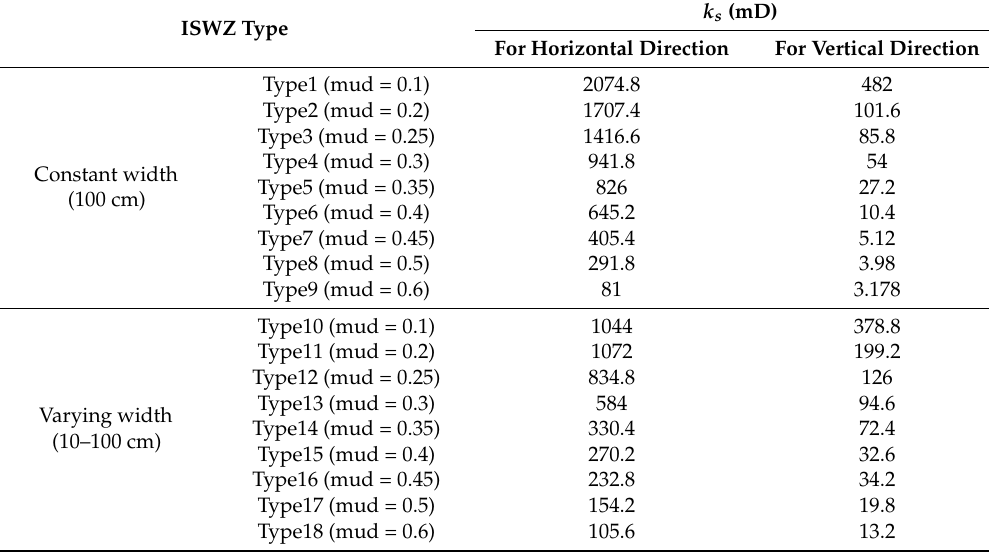
Table 6. The calculation results of k s for all the studied